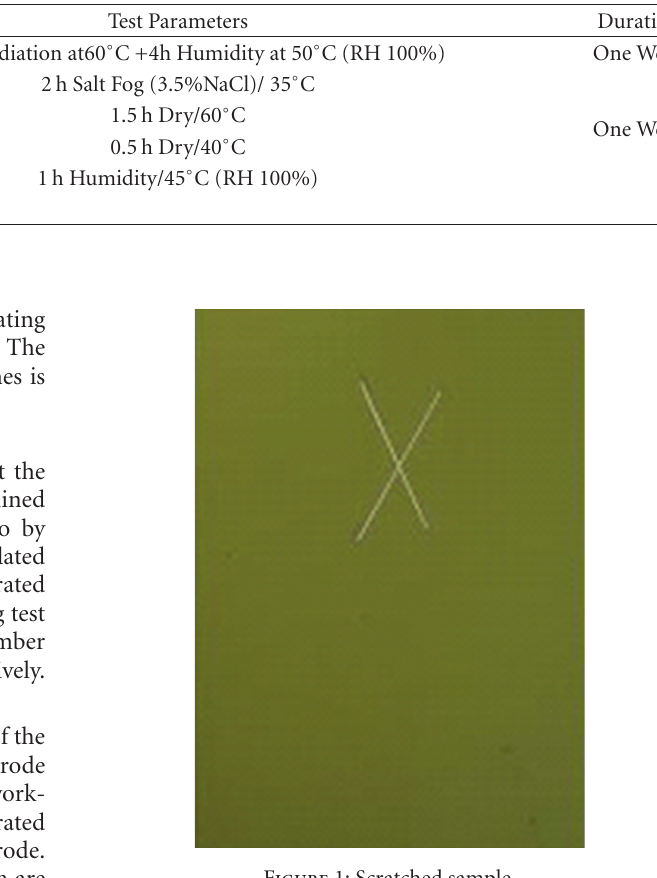
Figure 1: Scratched